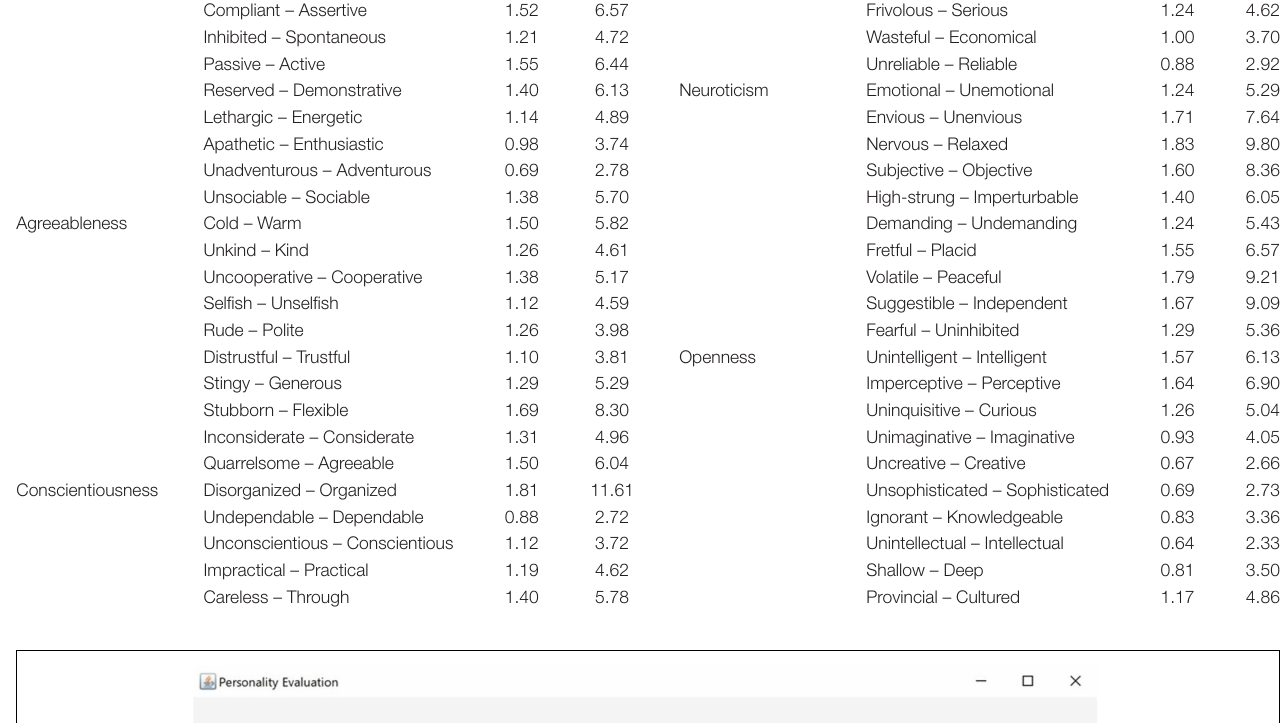
TABLE 4 | Mean values and Z -values of evaluation values.